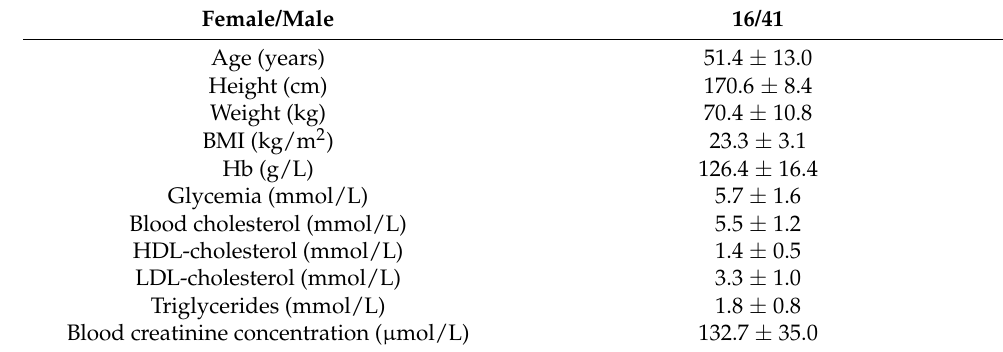
Table 1. Clinical characteristics of the study population ( n = 57) of kidney transplant recipients.